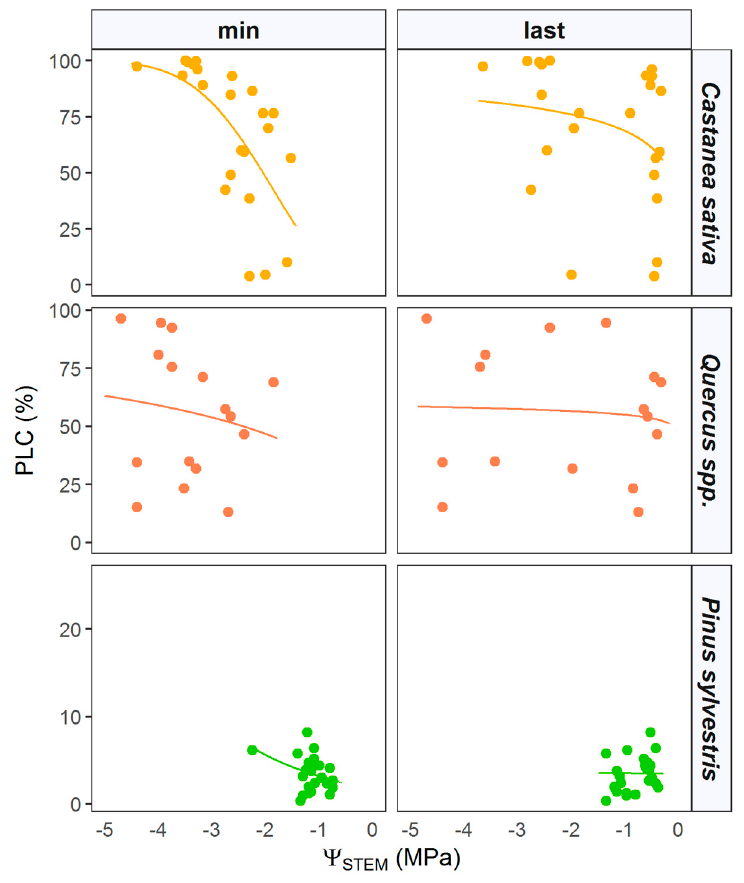
Figure 7. Relationships and corresponding Weibull function fits between the minimum recorded during the study period 2015 ( left panels) as well as the last recorded ( right panels) Ψ STEM and the percentage of loss of conductivity (PLC).